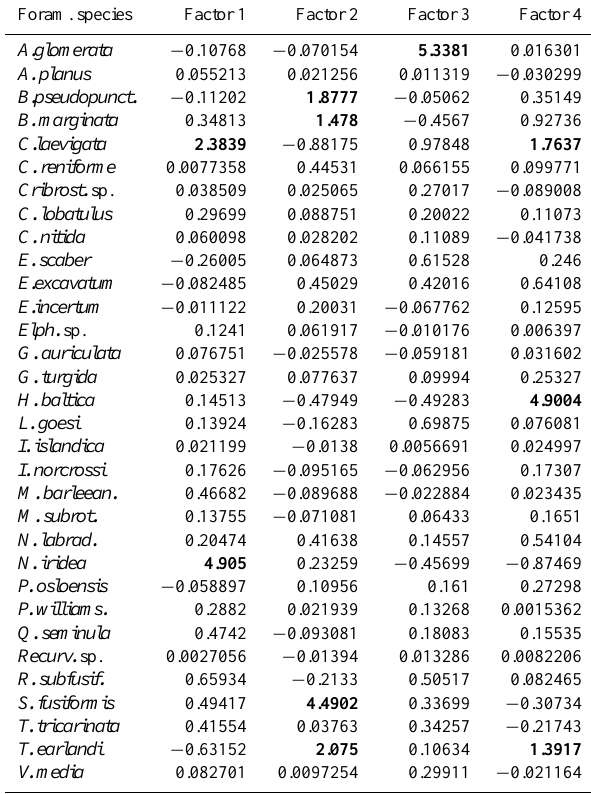
Table 3. The varimax scores for factors 1–4. The bold numbers indi- cate foraminiferal species with high ( > 1) absolute values of factor scores. Foram. species Factor